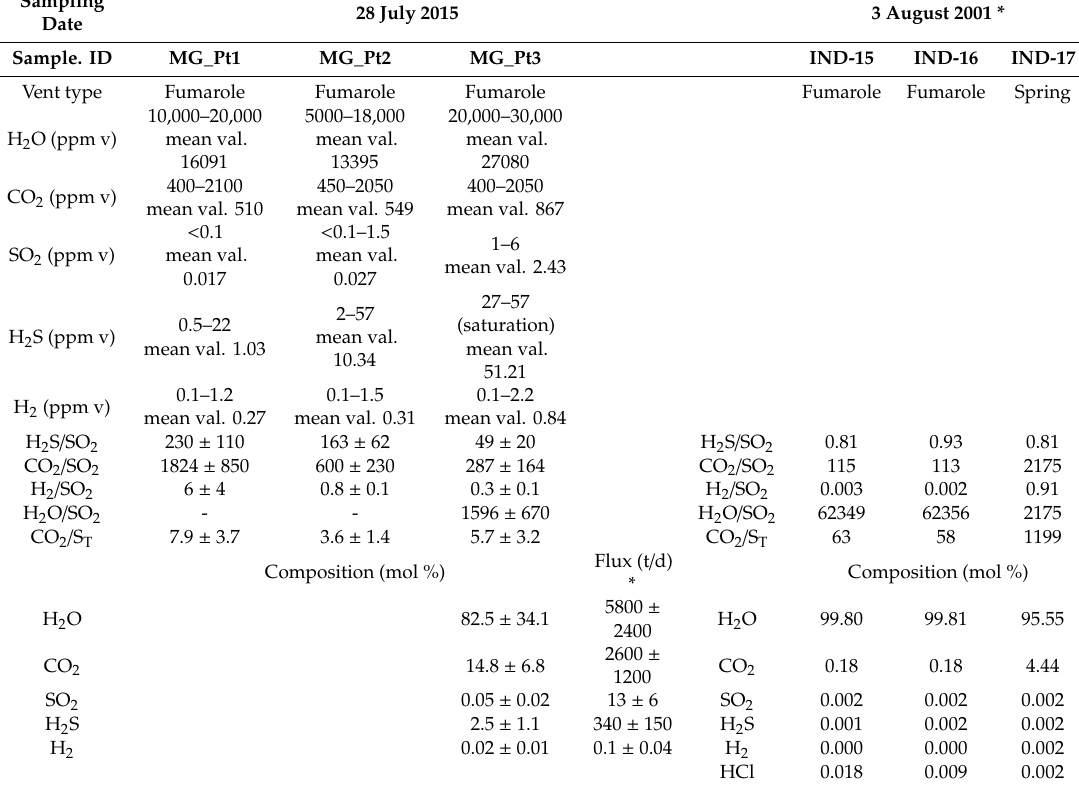
Table 3. Gas ratios, gas composition and gas fluxes from Awu volcano.